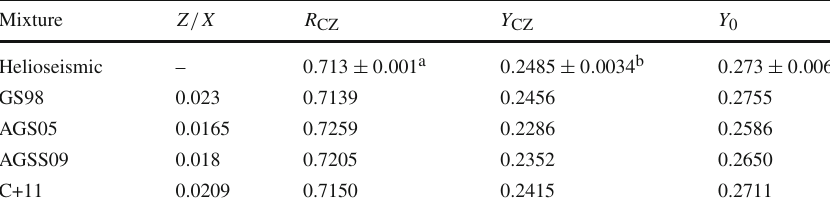
Table 3 Properties of standard solar models shown in Fig.